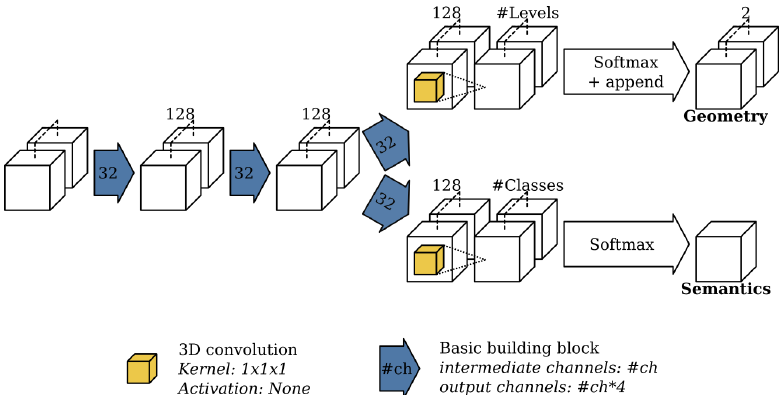
Figure 5. Overview of the subnetwork used to predict each group. The blue arrows represent the basic building block as shown in Figure 4. For each basic building block, the parameter value is displayed that represents the number of channels used by the 3D convolutions from the basic building